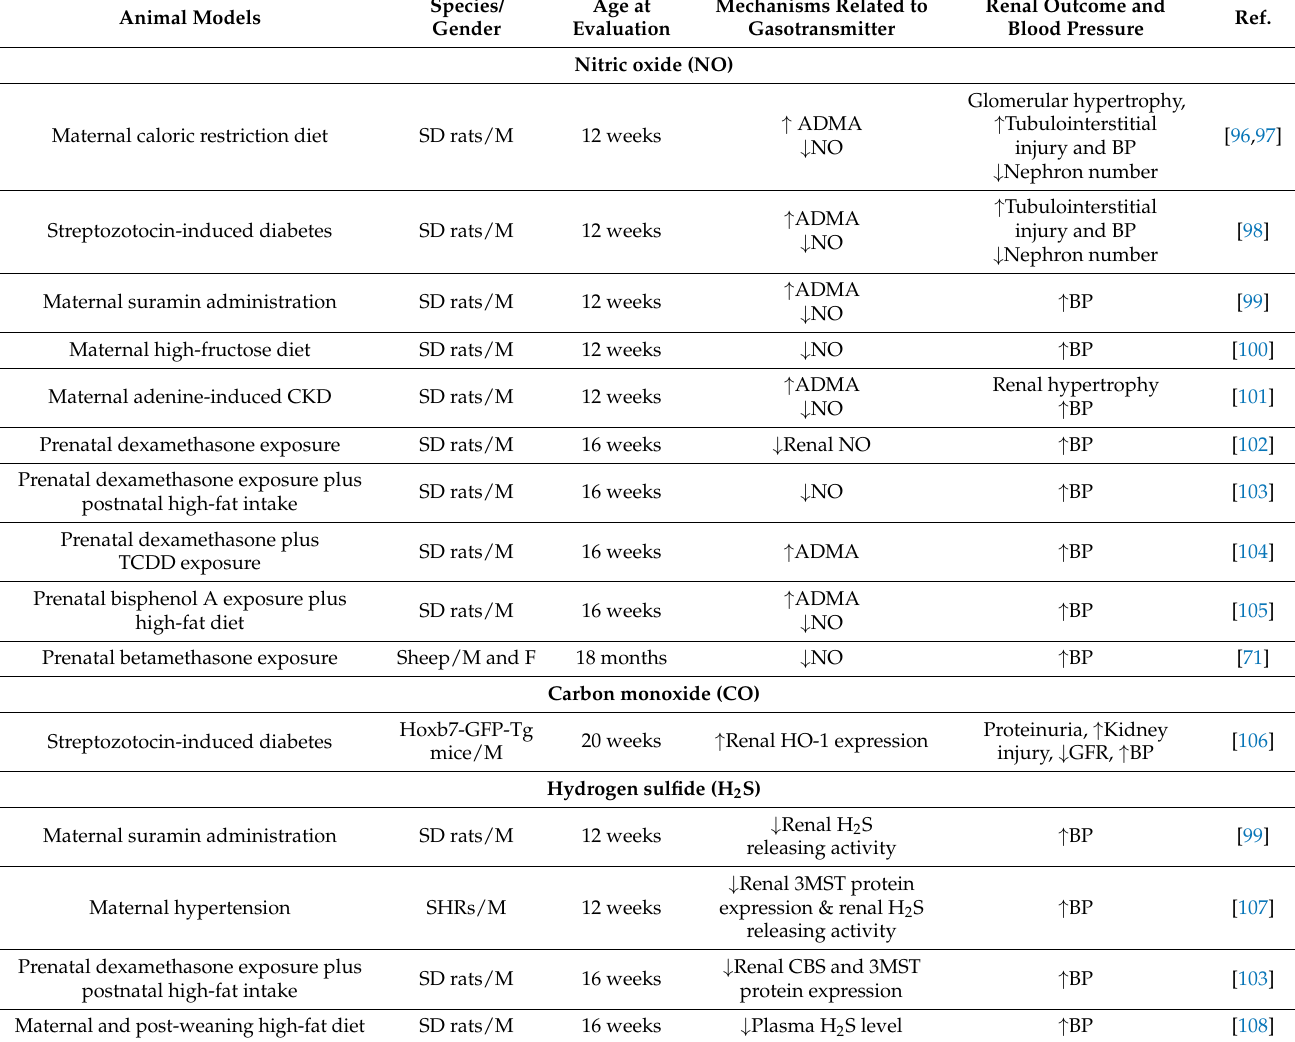
Table 2. Summary of animal models of renal programming related to NO, CO, and H 2 S signaling. Animal